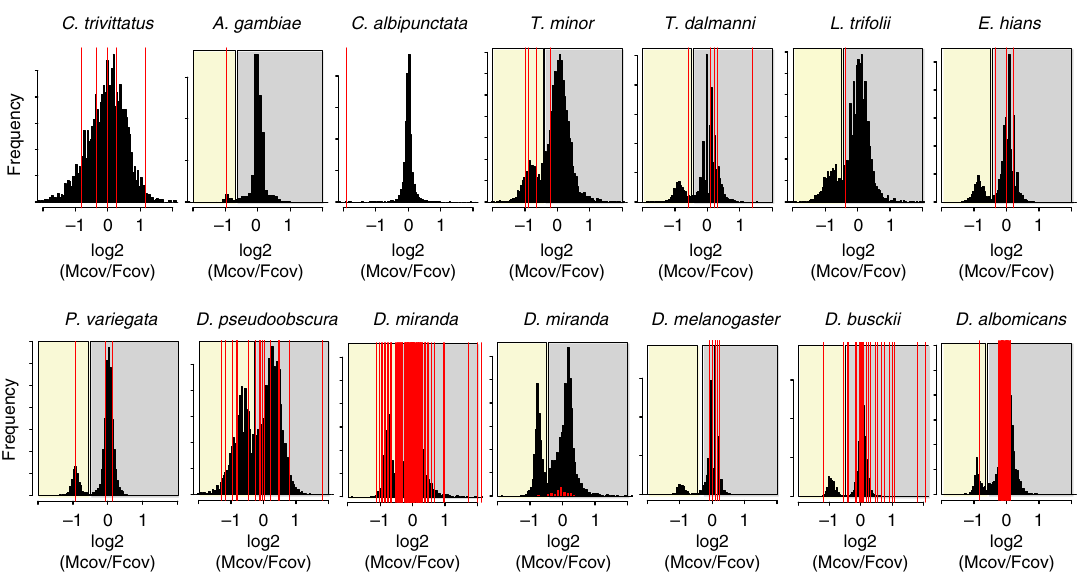
Fig. 4 Genomic coverage of paralogs of putative Y-linked genes. The histograms show the male/female genomic coverage ratio of all scaffolds in the female genome ( > 1000 bp). Scaffolds that are X-linked have reduced male/female coverage ratio (log2(Mcov/Fcov) around -1), while autosomal scaffolds have similar coverage in males and females (log2(Mcov/Fcov) around 0). The red lines indicate the male/female coverage ratio of scaffolds that have homologs on the Y chromosomes. Y-linked genes with X-linked homologs should show half the male/female coverage compared to ones with autosomal paralogs. Putative X-linked scaffolds are indicated by their yellow shading , and putative autosomal scaffolds are shown in grey shading . Note that we also show a histogram for paralogs of D. miranda Y-linked transcripts, due to the large number of Y-linked